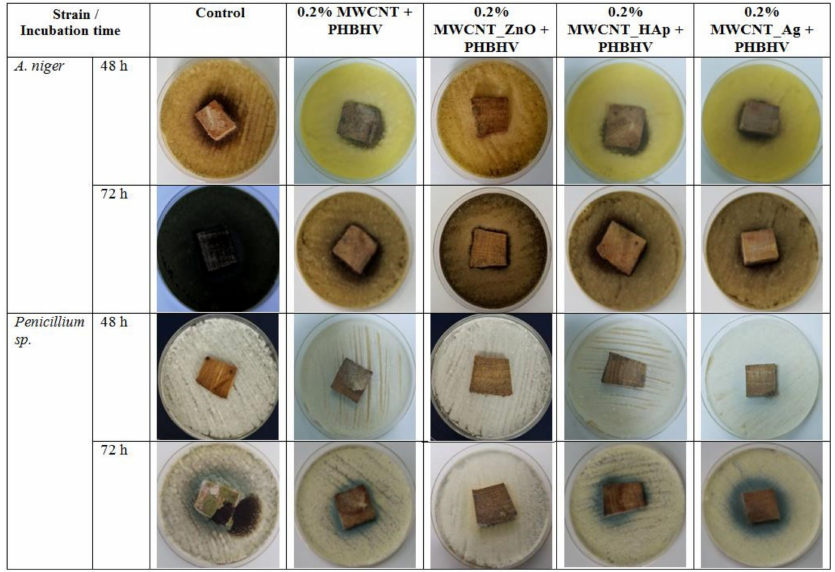
Figure 11. Images after antifungal test for untreated and treated wood